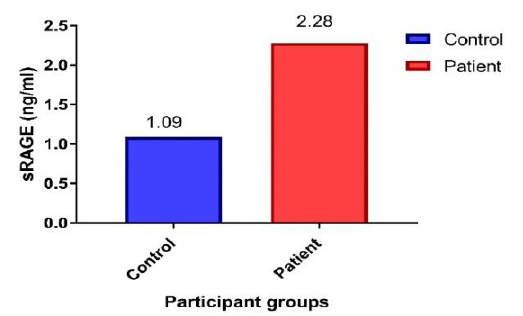
Figure2. Mean Values of sRAGE levels in Patient and Control